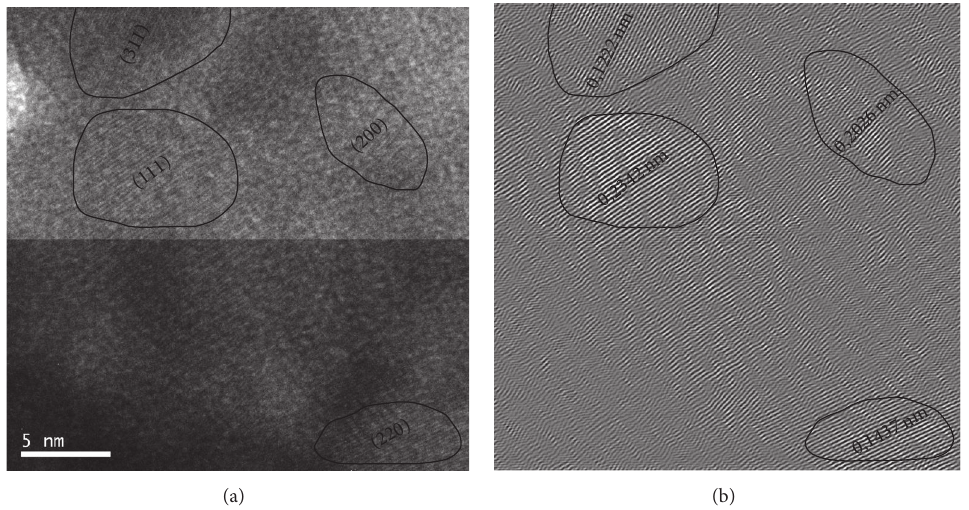
Figure 4: TEM image inside the particle structure of VN 𝑥 film (a) and its fast Fourier transform (b).